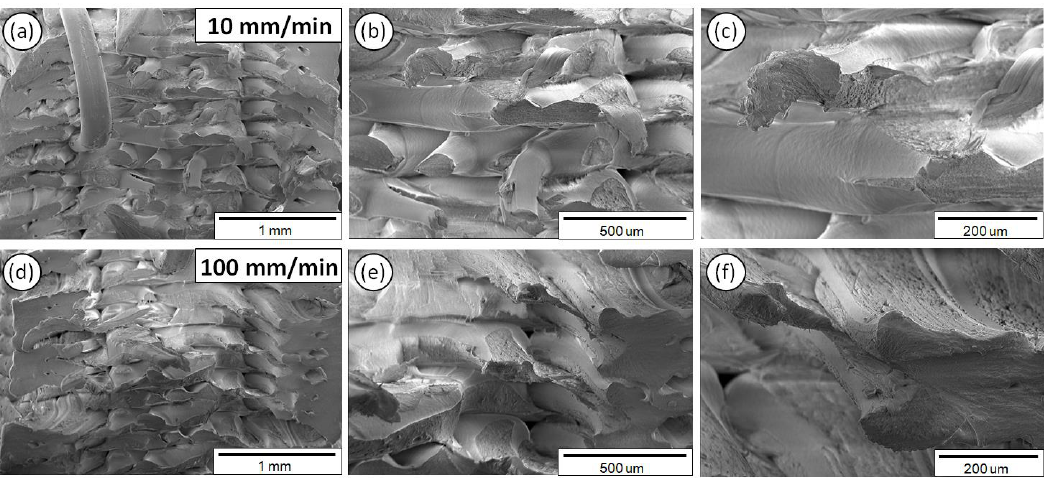
Figure 9. SEM images of ABS fractured surfaces at three different magnifications for the 10 ( a , b , c ) and 100 mm/min ( d , e , f ) strain rates.